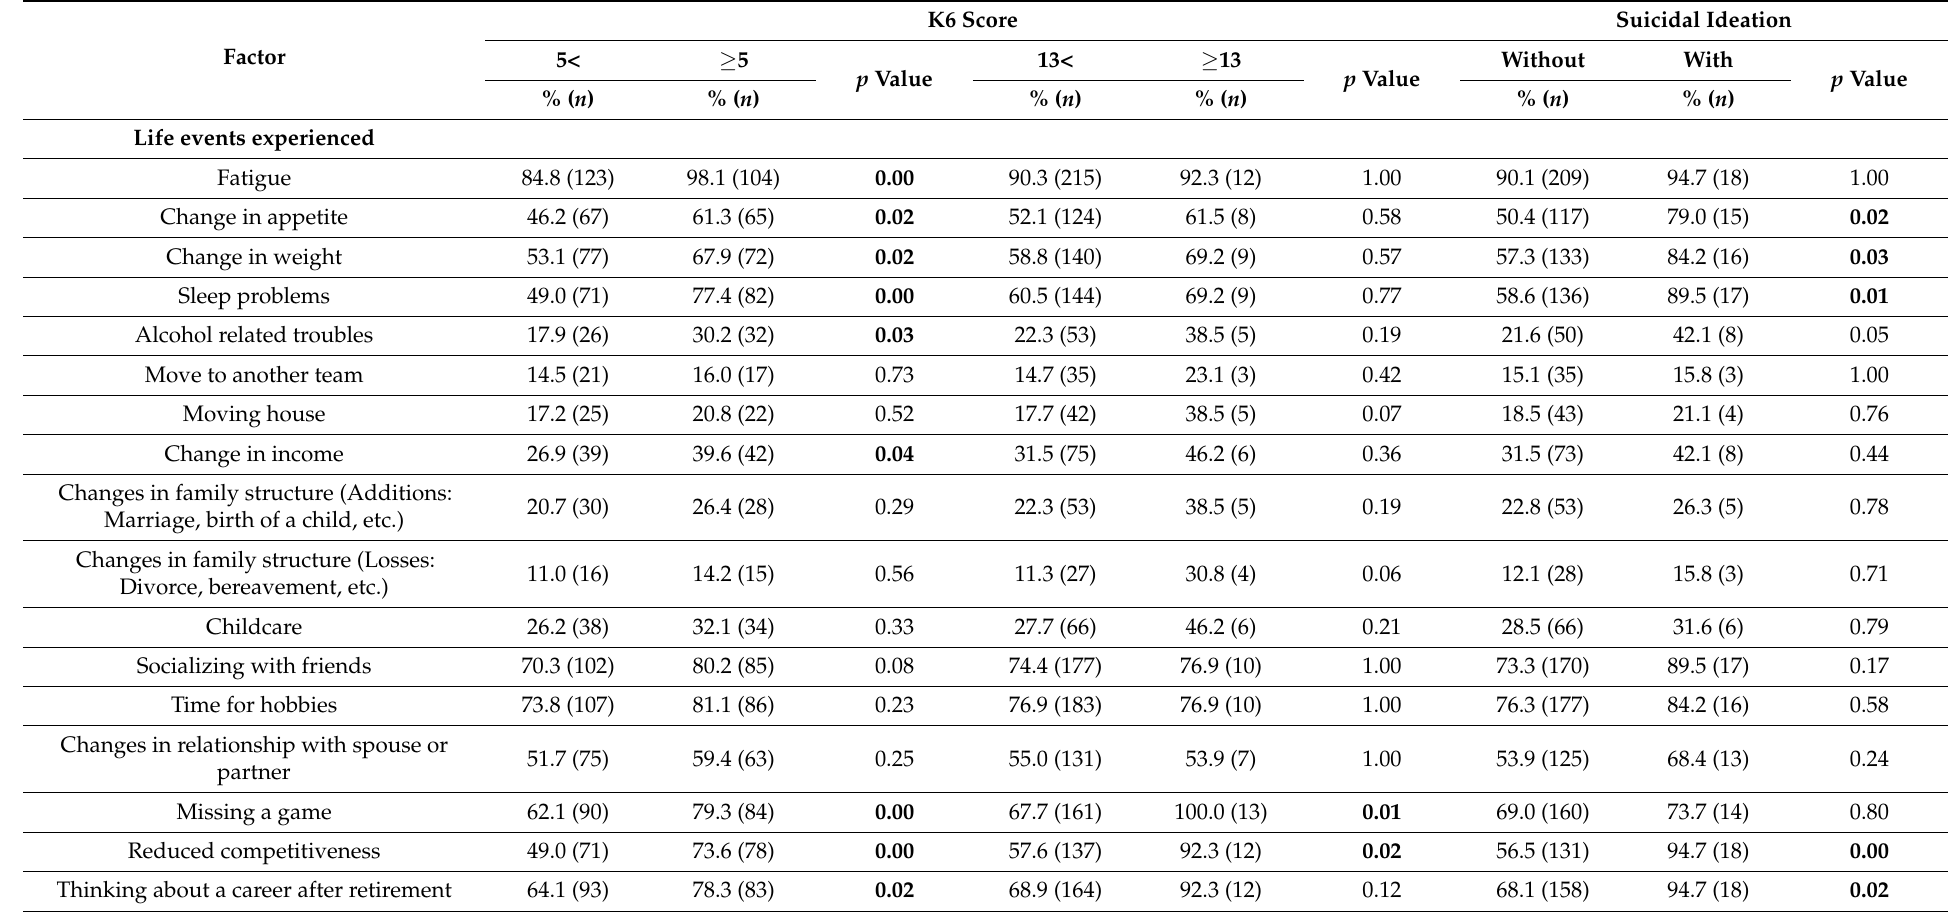
Table 3. Relationship of anxiety and depression symptoms and suicidal ideation to life events